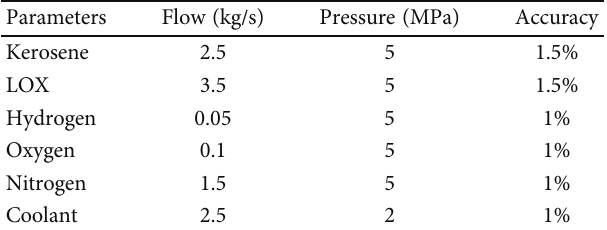
Figure 1: The structure diagram of the LRE test system. Table 1: Main parameters of the test